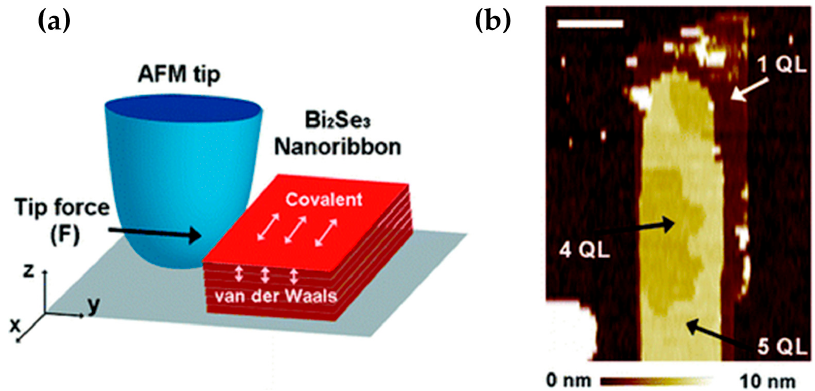
Figure 2. ( a ) Schematic of atomic force microscopy (AFM) exfoliation of layered structure nanomaterial-Bi 2 Se 3 nanoribbon; ( b ) Topographic image of an exfoliated nanoribbon with three different thicknesses (1 QL, 4 QLs, 5 QLs) in different regions [62].